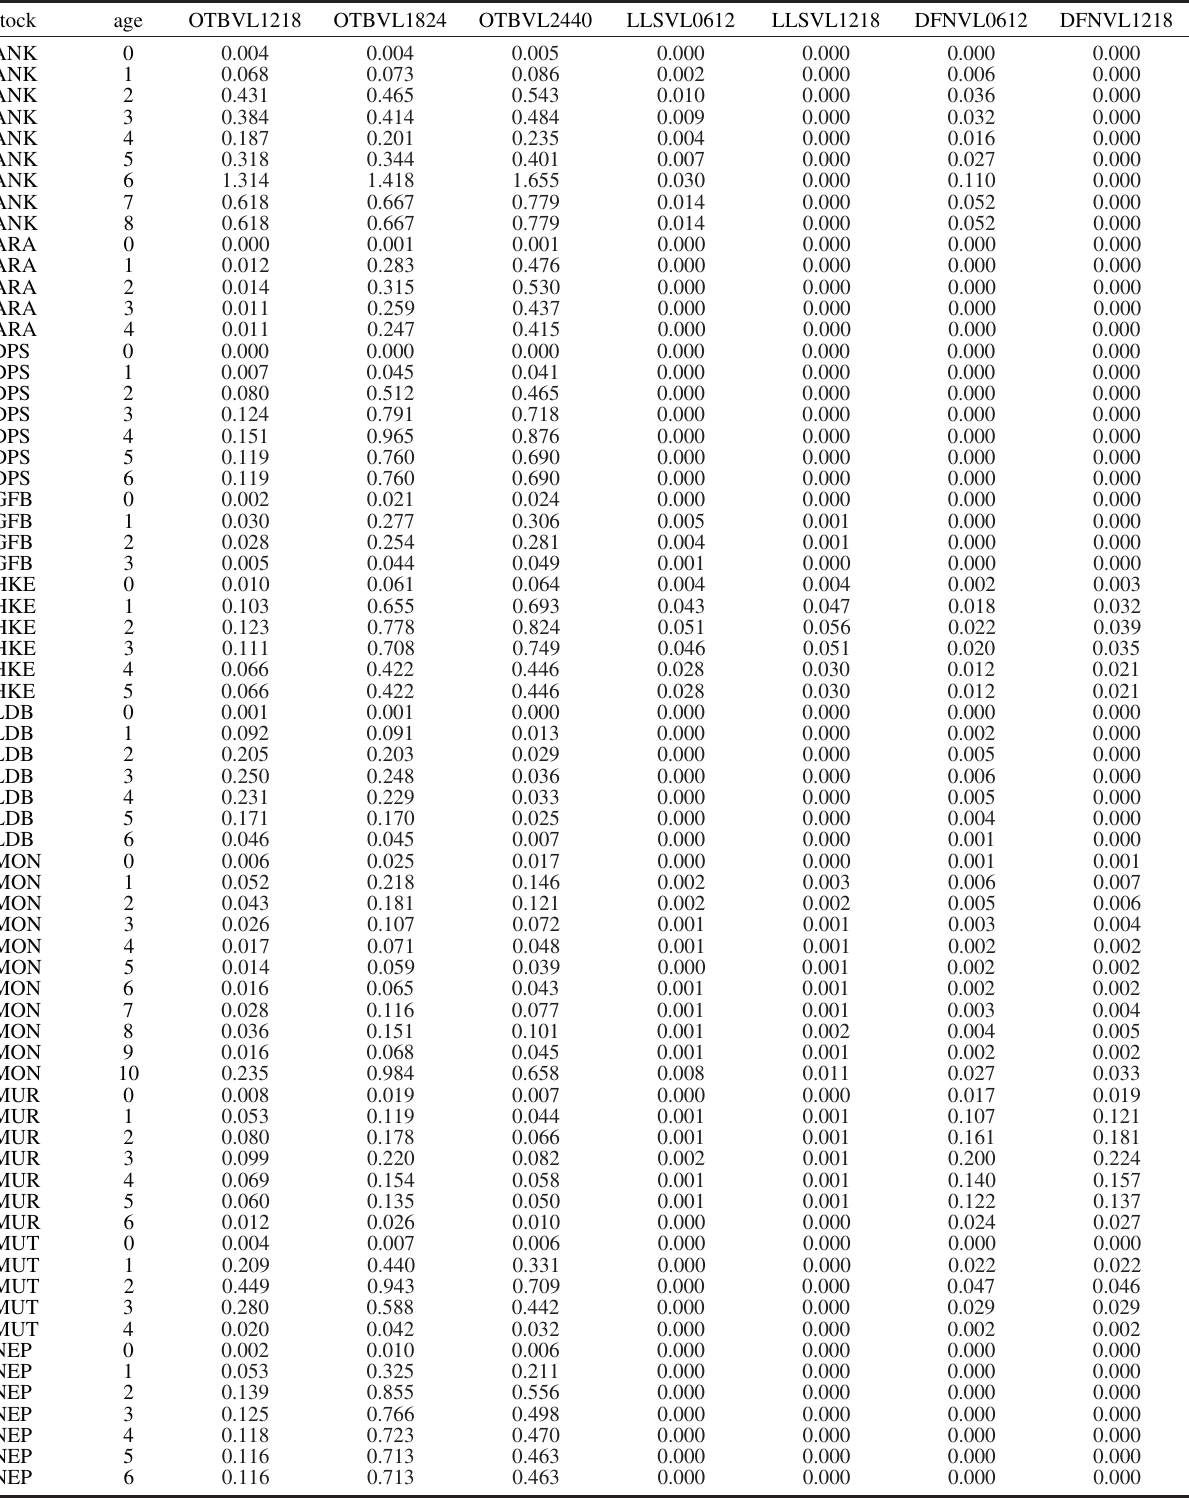
Table 4. – Fishing mortality. F at age by fleet for each stock. Fleet code indicates gear and vessel length (OTB, bottom otter trawl; LLS, longline; DFN, entangling nets). Species codes as in Table 1.